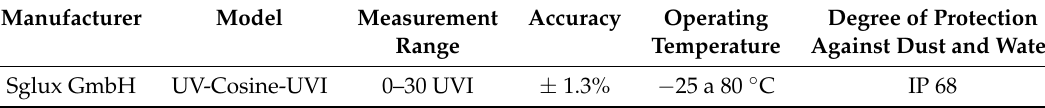
Table 2. Characteristics of the sensors for the measurement of UV radiation.